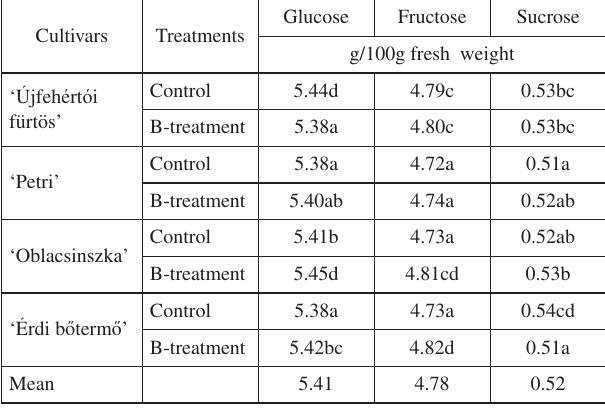
In each column, means followed by the same letter are not significantly different